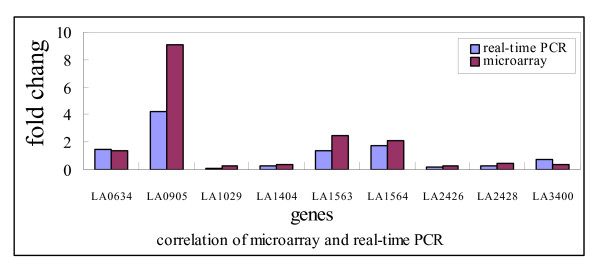
correlation of microarray and Real-time PCR. Comparison of transcription measurements by microarray (red bar) and real-time PCR assays (blue bar). The fold change ratios are shown for nine genes at 37°C compared with 28°C.